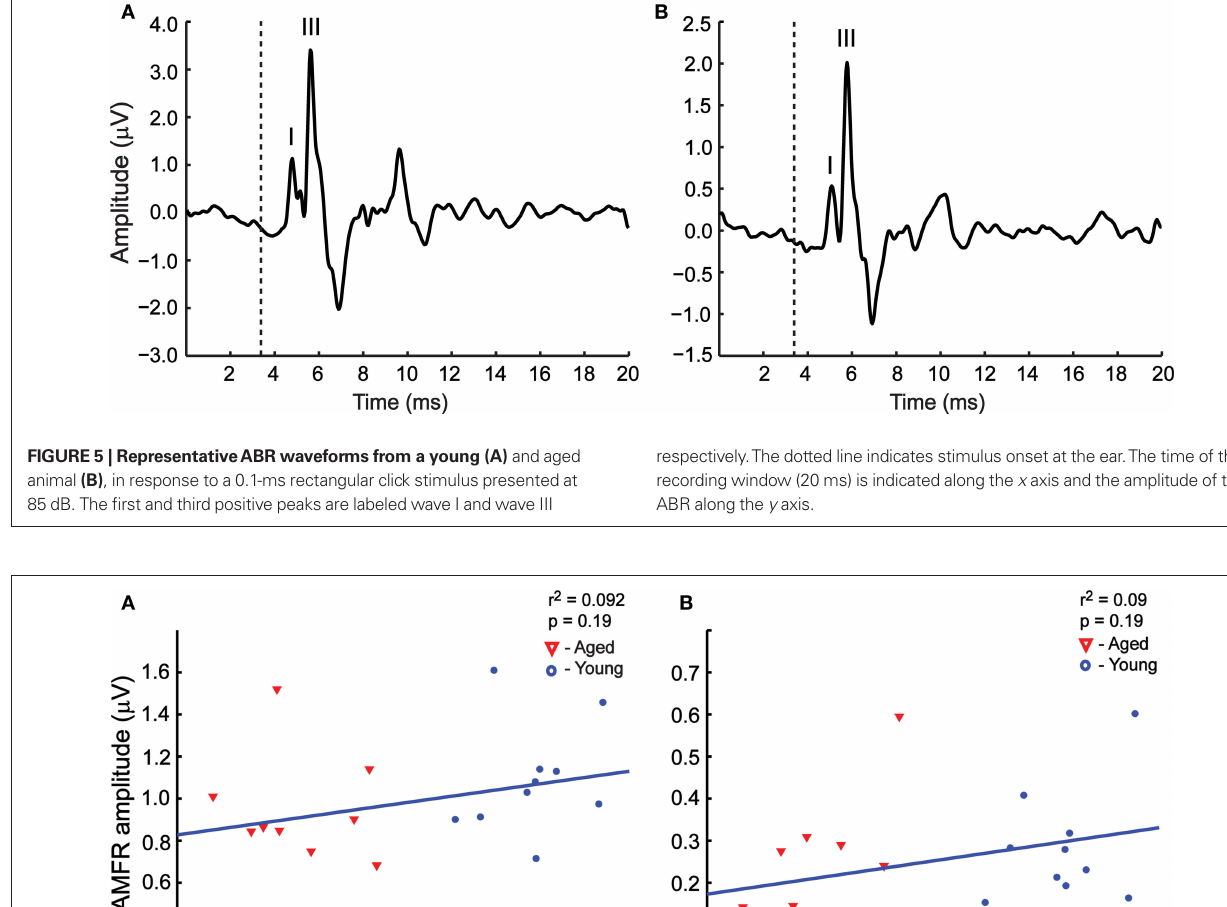
Figure 6 | There was no significant correlation between wave i amplitudes and the AMFr amplitudes at 30 dB above click threshold at both 256 Hz (A, r 2 = 0.092, P = 0.19) and 1024 Hz (B, r 2 = 0.092, P = 0.19) modulation frequencies. The ABR amplitudes for rectangular click stimuli at